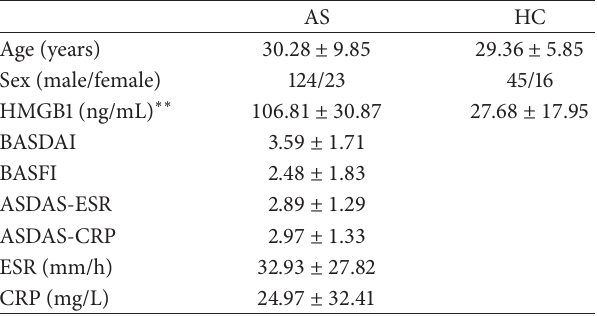
Table 1: Baseline characteristics of 147 ankylosing spondylitis patients.